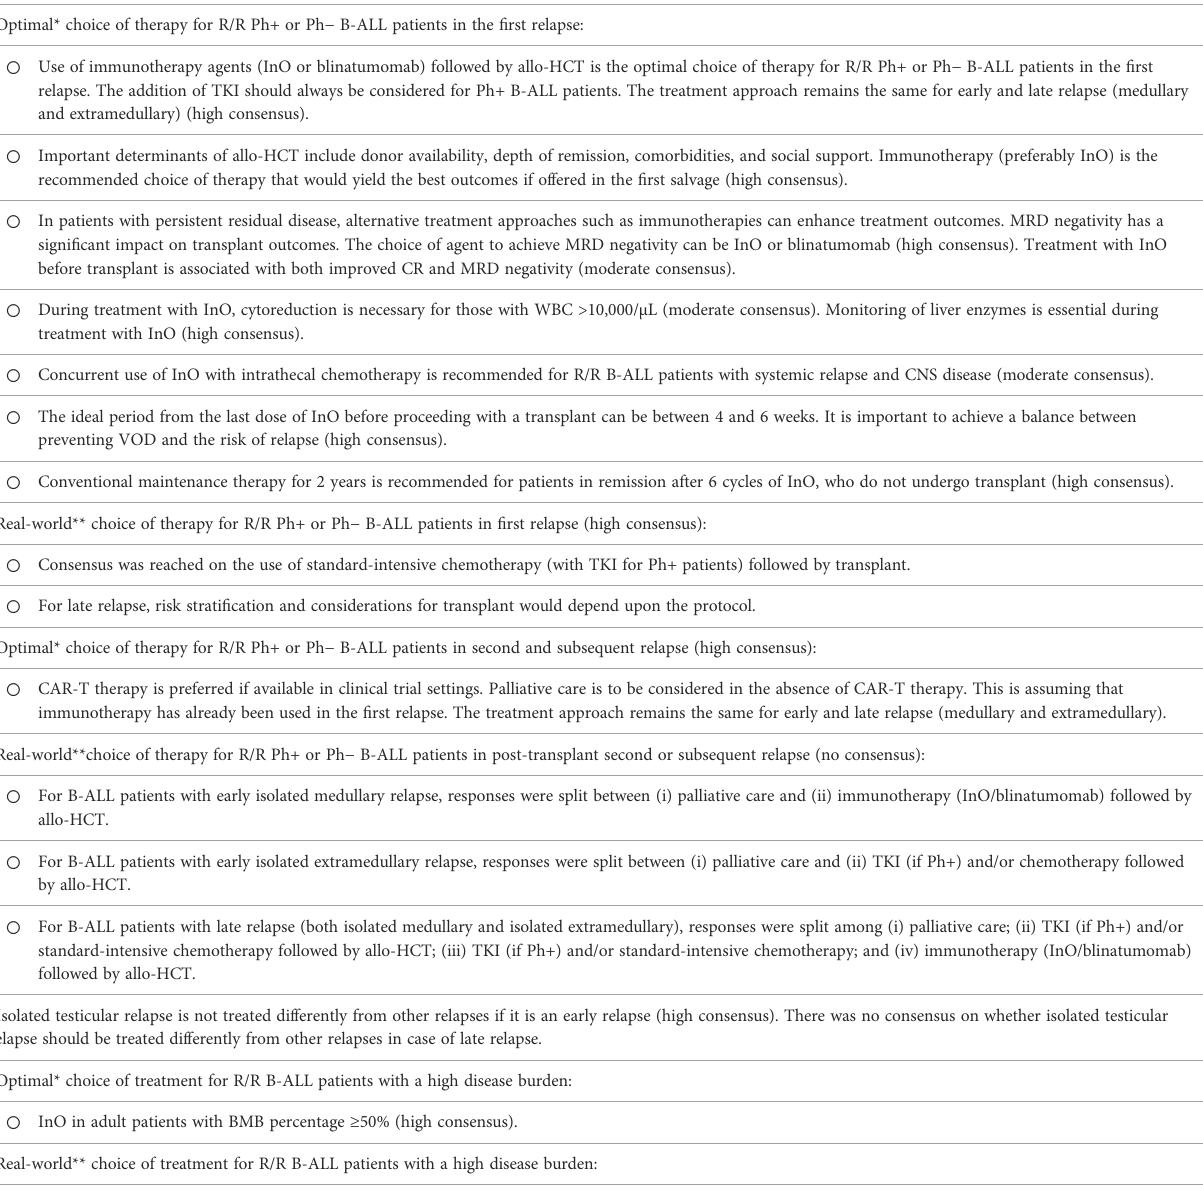
TABLE 5 Choice of therapy in relapsed/refractory B-ALL: Summary of expert consensus/recommendations. (cid:129) Optimal* choice of therapy for R/R Ph+ or Ph − B-ALL patients in the fi rst relapse: ○ Use of immunotherapy agents (InO or blinatumomab) followed by allo-HCT is the optimal choice of therapy for R/R Ph+ or Ph − B-ALL patients in the fi rst relapse. The addition of TKI should always be considered for Ph+ B-ALL patients. The treatment approach remains the same for early and late relapse (medullary and extramedullary) (high